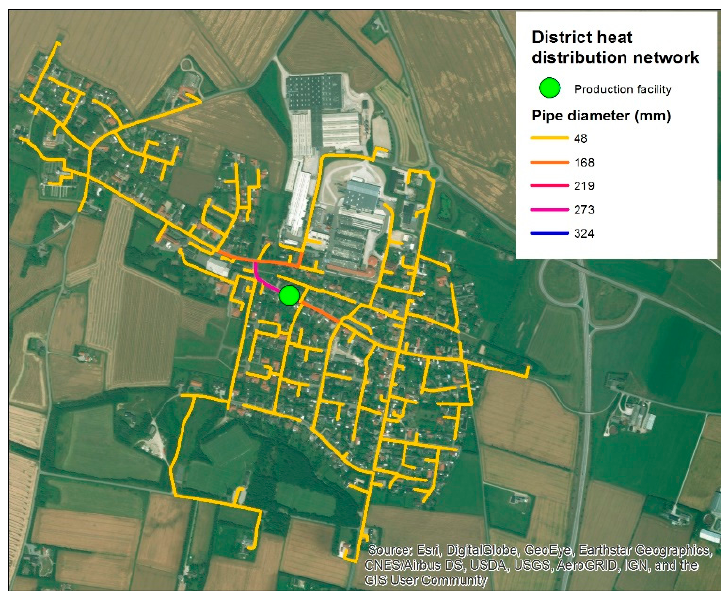
Figure 6. Example of distribution network generated by the model.